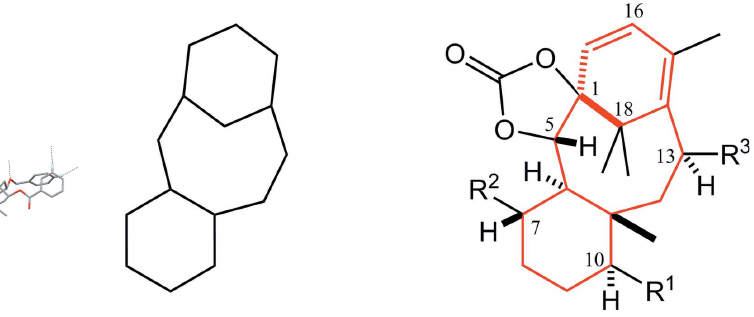
Figure 1 Left: Structure of the tricyclo[9.3.1.0 3,8 ]pentadecane (taxane) skeleton; Right: The title compound, indicating the taxane skeleton with red lines. R 1 = OC( O)Ph, R 2 = OCH 2 OCH 3 , R 3 = OCH 2